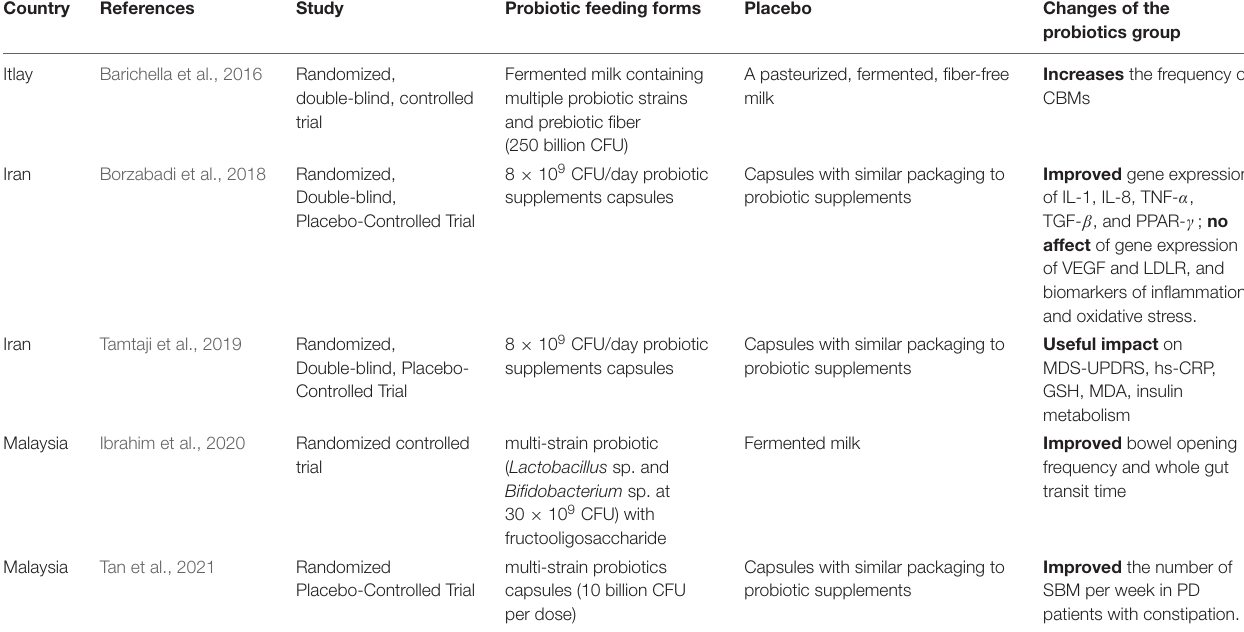
TABLE 2 | Effect of probiotics on Parkinson’s disease